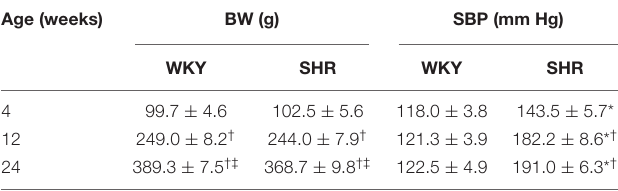
TABLE 1 | Body weight and systolic blood pressure measured in a conscious state. Age